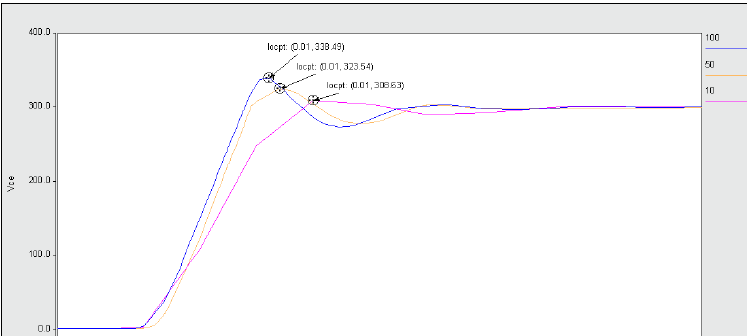
Figure 7. V ce comparison diagram under different R 4